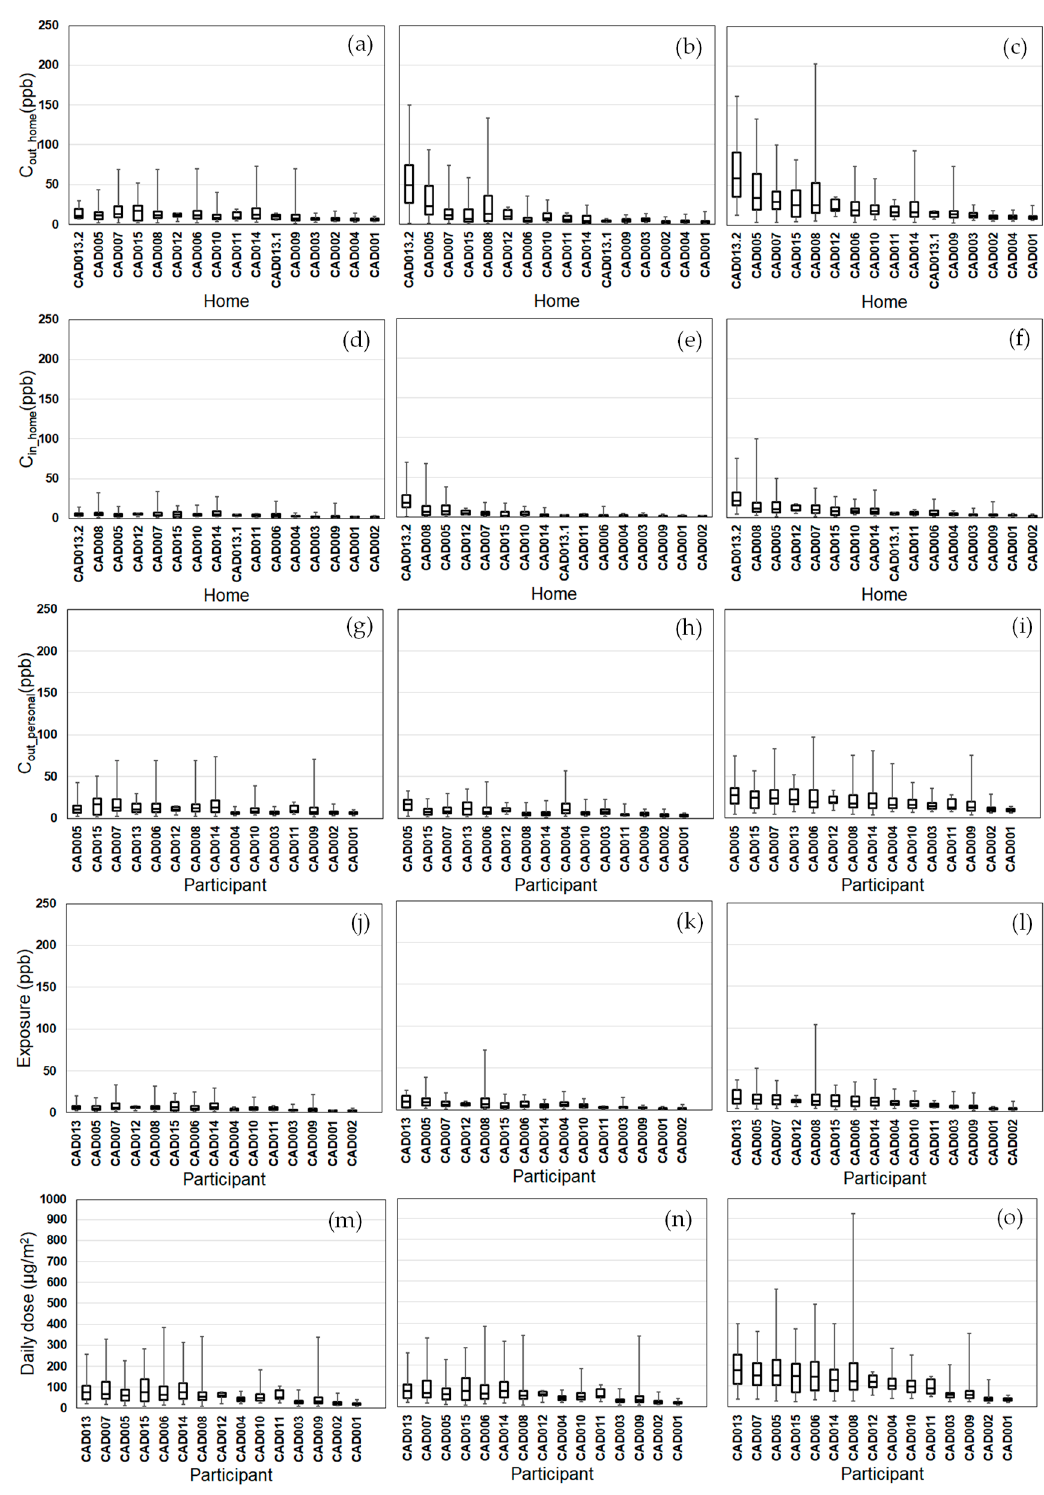
Figure 4. Modeled NO x exposure metrics for Tier 1 (outdoor home concentrations; a – c ), Tier 2 (indoor home concentrations; d – f ), Tier 3 (personal outdoor concentrations; g – i ), Tier 4 (exposures; j – l ), Tier 5 (inhaled dose; m – o ) from background ( a , d , g , j , m ), on-road vehicle emissions ( b , e , h , k , n ), and total NO x ( c , f , i , l , o ). Results (24 h average, 08:00–08:00) are sorted by total NO x median values from highest to lowest. Shown are medians with 25th and 75th percentiles, and whiskers for minimum and maximum values.